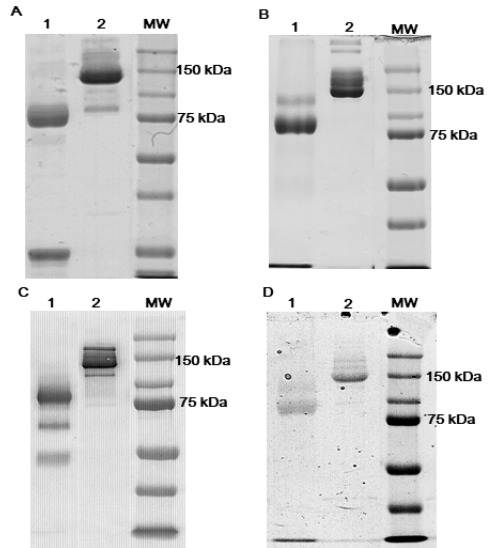
Figure 1. Non-reducing SDS-PAGE of reduced antibodies: anti-cTnI ( A ), anti-FERR ( B ), anti-AFP ( C ) and anti-fPSA-ACT ( D ). Lanes 1, reduced antibodies; lanes 2, whole antibodies. cTnI, cardiac troponin I; FERR, ferritin; AFP, alpha-fetoprotein; PSA-ACT, prostate-specific antigen-alpha(1)- antichymotrypsin.